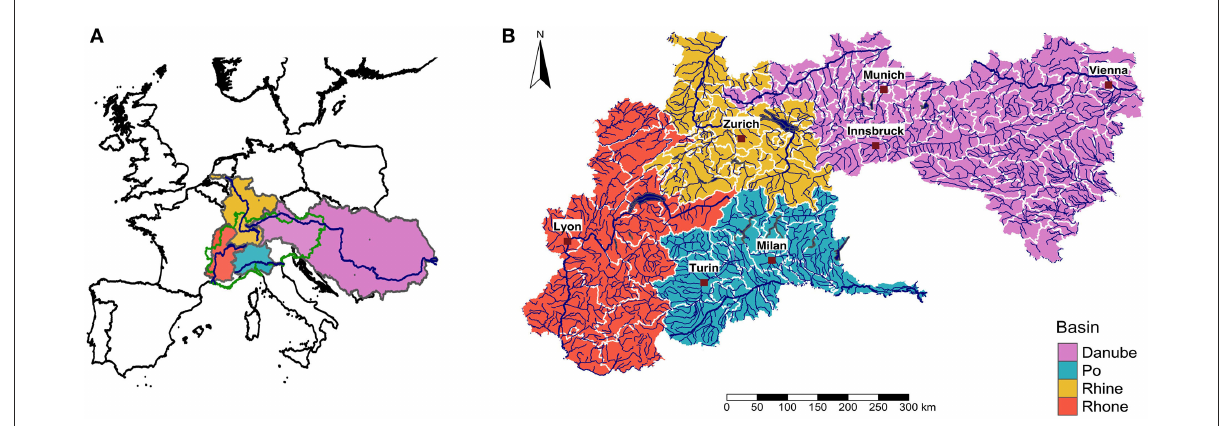
FIGURE1 (A) The Rhine, Rhone, Po and Danube basins in Europe and the Alpine Space extent of the basins (marked with a green line), (B) the NUTS 3 regions of the river basins within the extent of the Alpine Space.